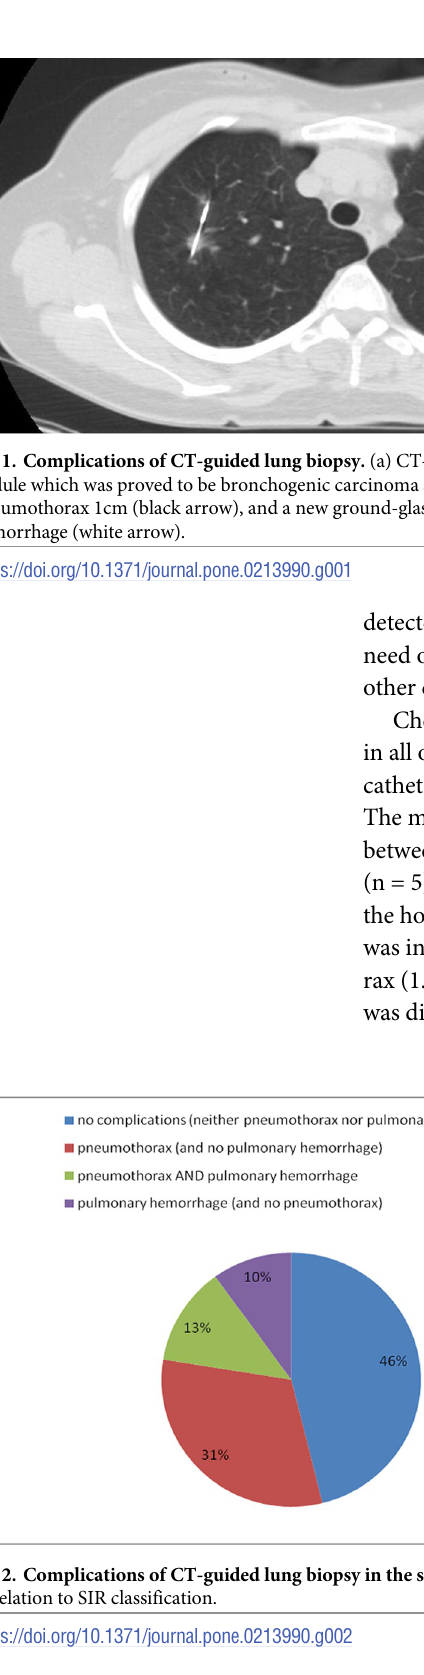
PLOS ONE | https://doi.org/10.1371/journal.pone.0213990 March 18,